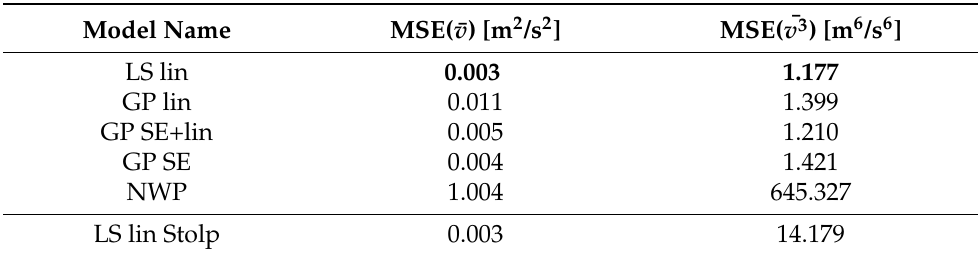
Table 4. Wind speed distribution-related figures of merit for various models of wind speed at Brežice meteorological station and for LS lin model at Stolp meteorological station. The wind speed and the cube of the wind speed are averaged over the 11-month test period for each model to obtain ¯ v and ¯ v 3 . The difference between ¯ v or ¯ v 3 obtained with model prediction and ¯ v or ¯ v 3 obtained from the measurement is computed, squared, and the 12 squares that correspond to the 12 train/test data set selections are